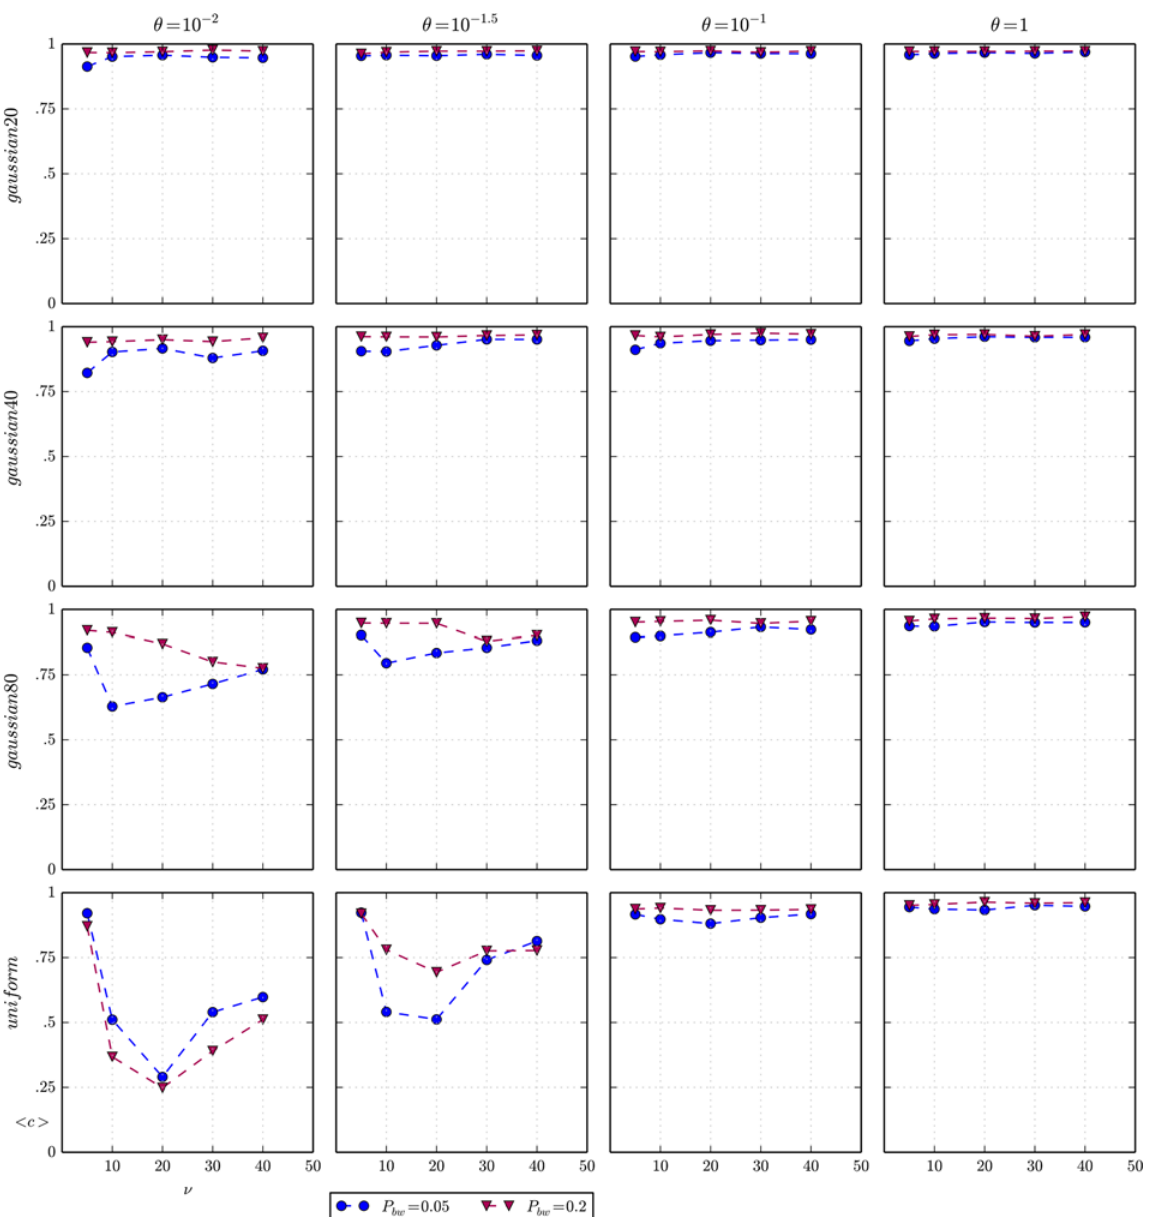
Fig 7. Average cooperation and spatial distribution of beached whales. Matrix of plots of the average cooperation < c > as a function of vision v for different spatial distributions of beached whales (columns) and levels of importance of social capital θ (rows), when the agents ’ movement is a random walk. The maximum standard error of the average of cooperation of all experiments represented in the plots is